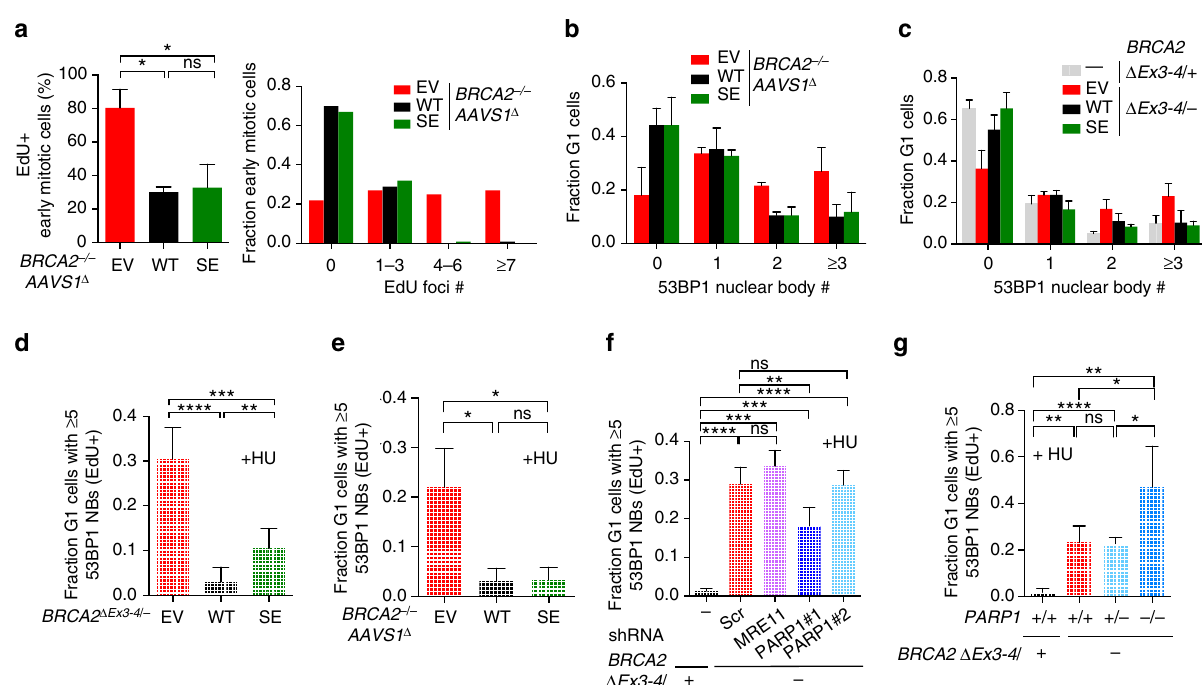
Fig. 6 Fork protection is a minor replication stress suppression pathway. a Analysis of mitotic DNA synthesis in BRCA2 – / – AAVS1 Δ cells complemented by BRCA2 WT or BRCA2 SE. Cells were released for 22 h from serum starvation to increase mitotic cells, incubated with EdU 1 h, and then analyzed for mitotic DNA synthesis. Early mitotic cells, de fi ned as being in prophase, prometaphase, or metaphase, were analyzed for EdU foci that co-localize with FANCD2 foci pairs. The percent early mitotic cells containing EdU foci ( left , n = 3) or EdU foci distribution in these cells ( right , pooled results of three independent experiments) was quanti fi ed. b , c Spontaneous 53BP1 nuclear body analysis in G1 in both BRCA2 Δ Ex3-4/ – cells ( b ) and BRCA2 – / – AAVS1 Δ cells ( c ) complemented by BRCA2 WT or BRCA2 SE. n ≥ 3. d – g HU-induced 53BP1 nuclear body formation analysis, as in Fig. 4d, using complemented BRCA2 Δ Ex3-4/ – cells ( d ) or BRCA2 – / – AAVS1 Δ cells ( e ), stable MRE11 or PARP1 knockdown BRCA2 Δ Ex3-4/ – cells ( f ), and BRCA2 Δ Ex3-4/ – cells with